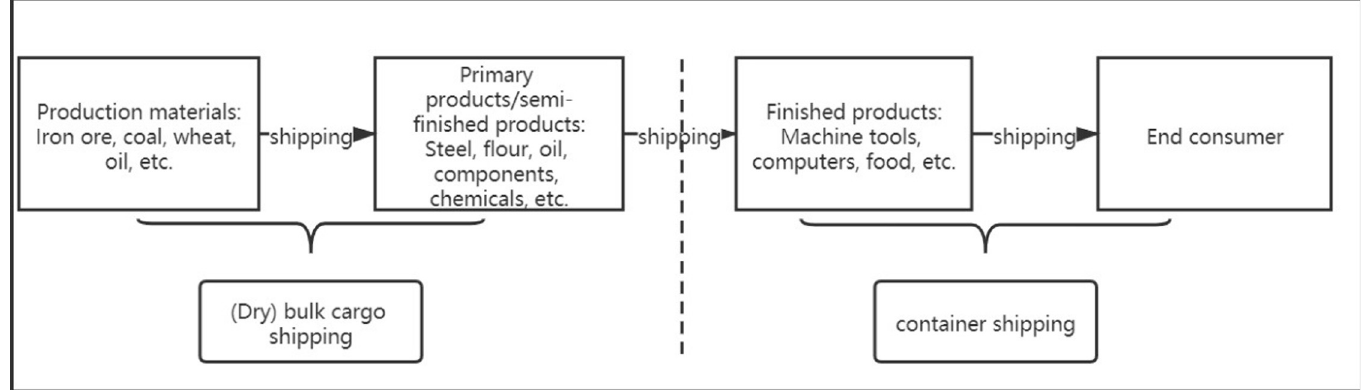
Fig 2. Role of dry bulk shipping in global